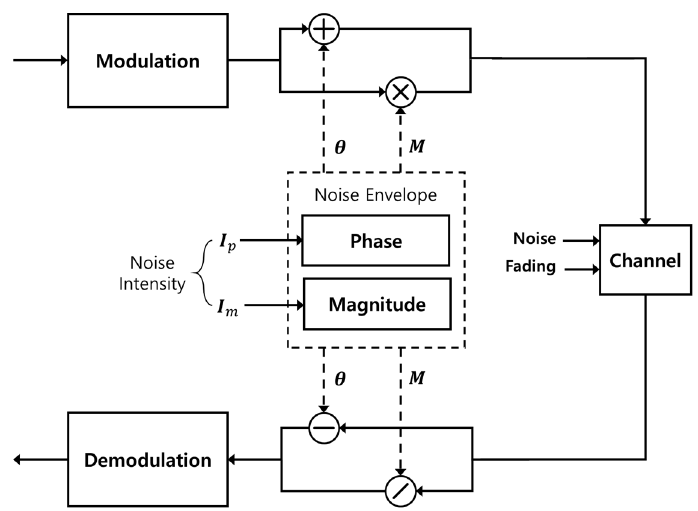
Figure 1. Ring-shaped signaling system block diagram.